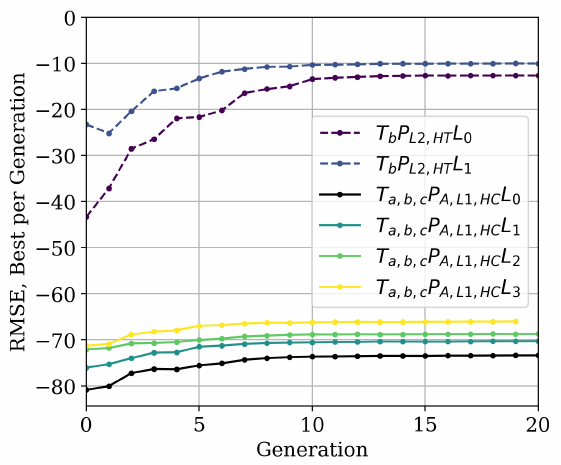
Figure 5. RMSE values for IMP runs with adjusted parameter sampling limits. Successive limit adjustments are marked with L ∗ .